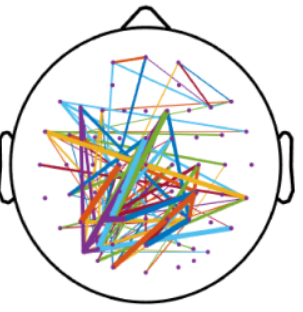
Figure 8. Functional brain connectivity when saying